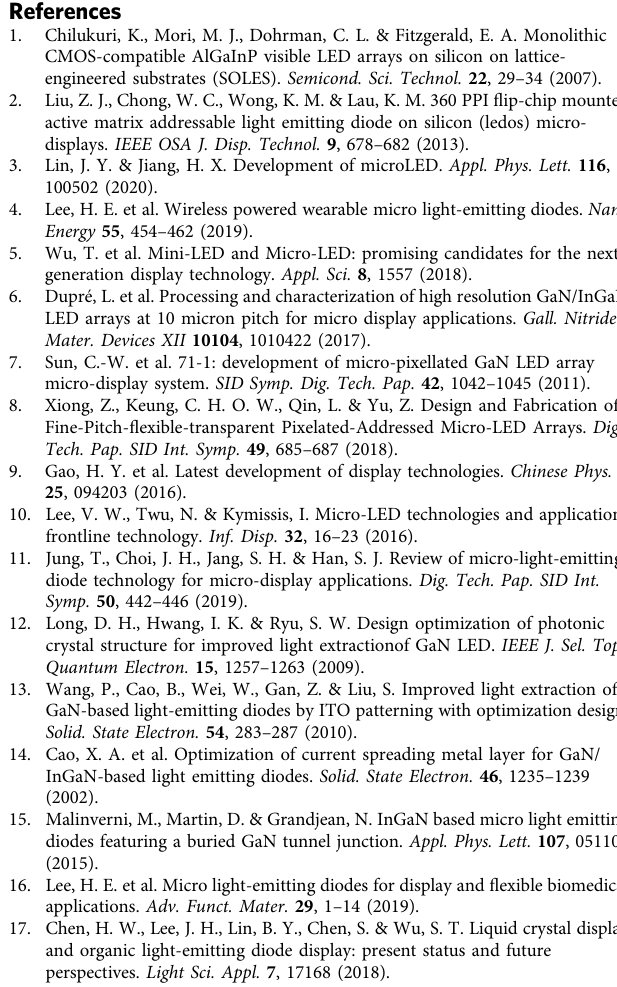
reducing the optical crosstalk and improving color purity.